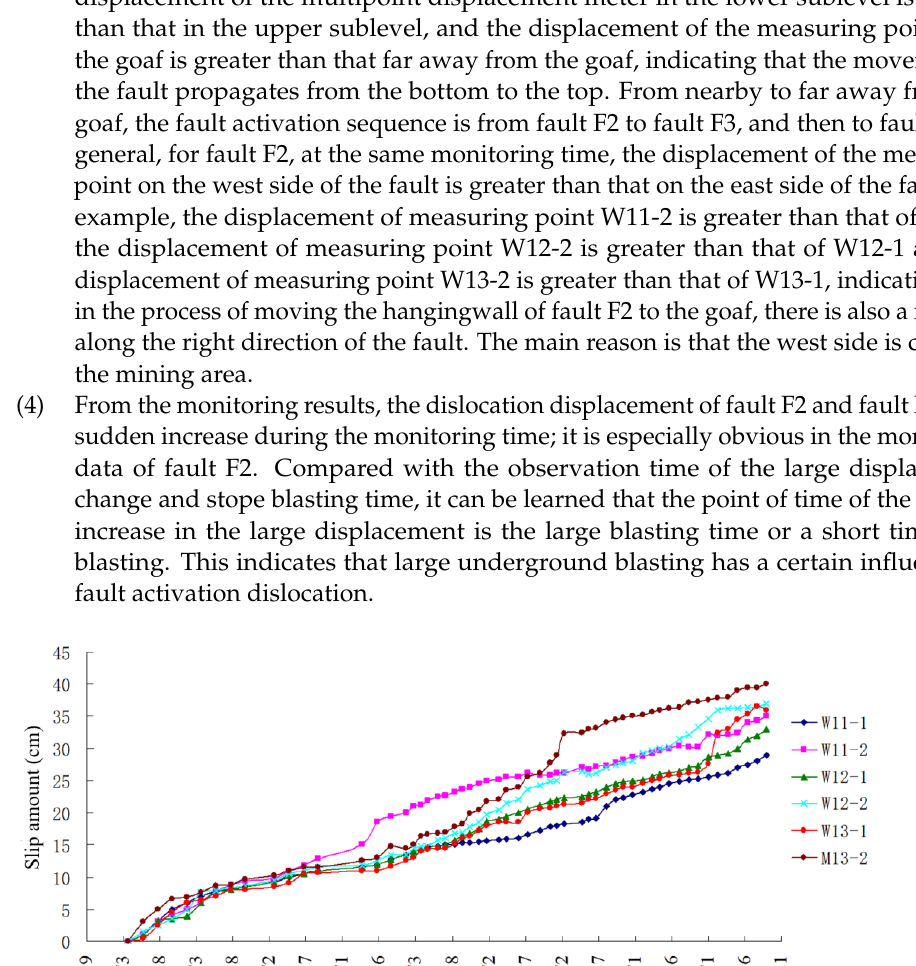
Figure 12. Multipoint displacement meter monitoring displacement–time curve of each measure- ment point of fault F3. Figure 13. Multipoint displacement meter monitoring displacement–time curve of each measure- ment point of fault F4.